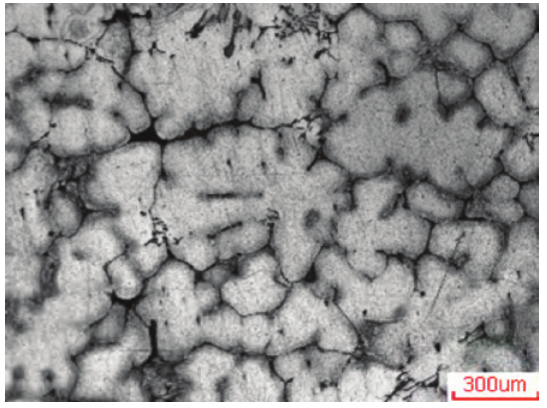
amount of barreling for each specimen [8], the barreling factor b is defined as follows: